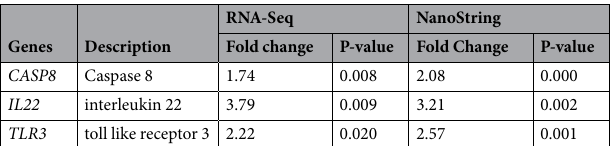
Table 5. Fold change and P-value for target genes ( CASP8 , IL22 , TLR3 ) based on the results from RNA-Seq and NanoString. Results from three biological replicates (n = 3). One biological replicate of each sample consisted of IEL-28.4 + cells harvested from 8 chickens. * The control samples were compared with 3 dpi